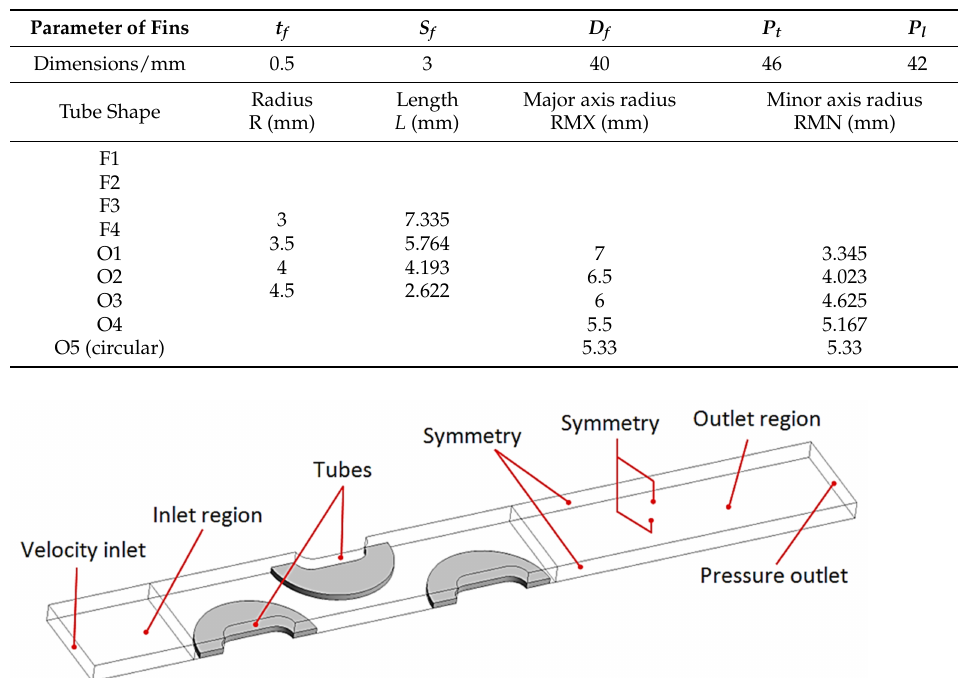
Table 1. Annular fins and tube shape dimensions.